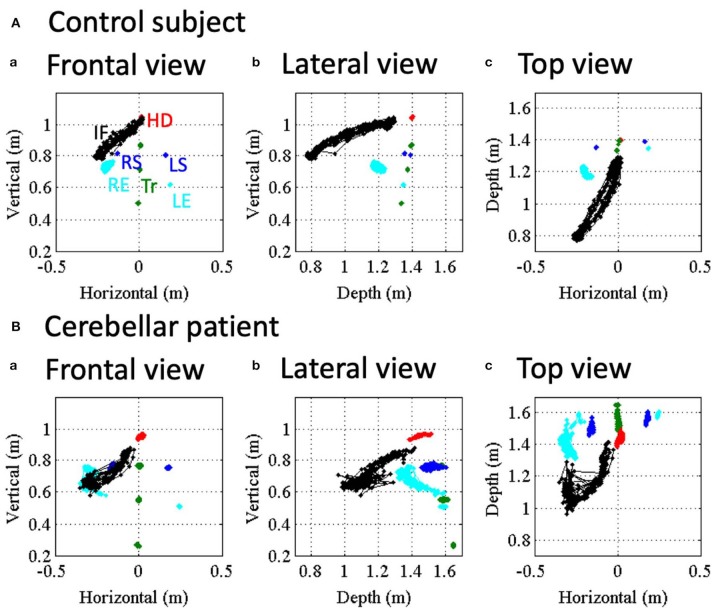
Movement kinematics of reference points in the nose-finger test for a control (A) and an ataxic patient. (B) Red, blue, cyan and black dots show positions of HD, shoulders (RS/LS), elbows (RE/LE) and IF, respectively. Trunk (Tr) consists of SS, PS and MS (green dots). (a–c) Correspond to frontal view, lateral view and top view, respectively.